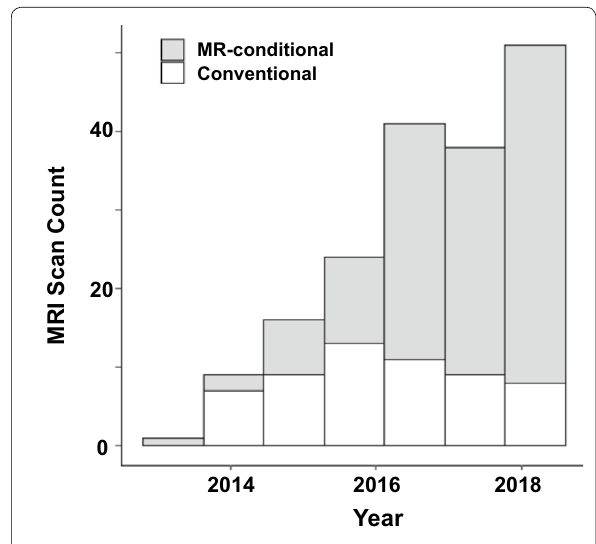
Fig. 3 Trend of MRI scan in the patients with CIEDs in the Seoul National University Bundang Hospital. The number of MRI scan in patients with CIED has gradually increased. The proportion of MR‑conditional CIEDs among the patients underwent MRI scan has also increased. CIED cardiac implantable electronic device, MRI magnetic resonance